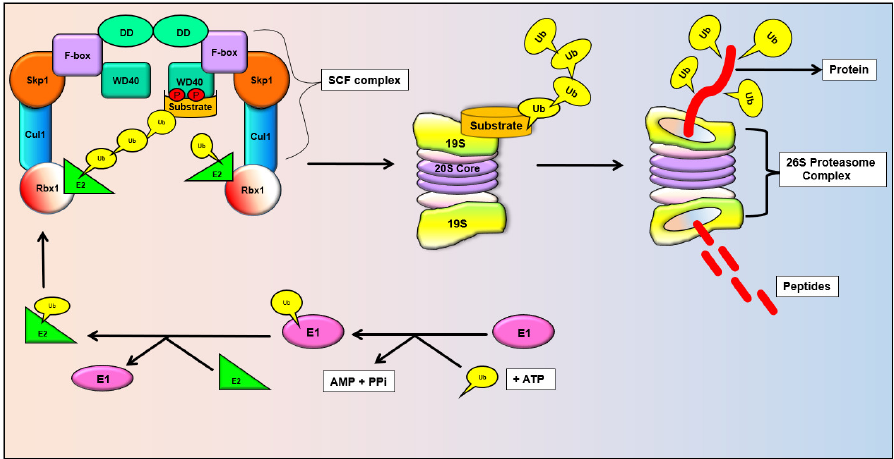
Figure 1. Mode of function of FBXW7.